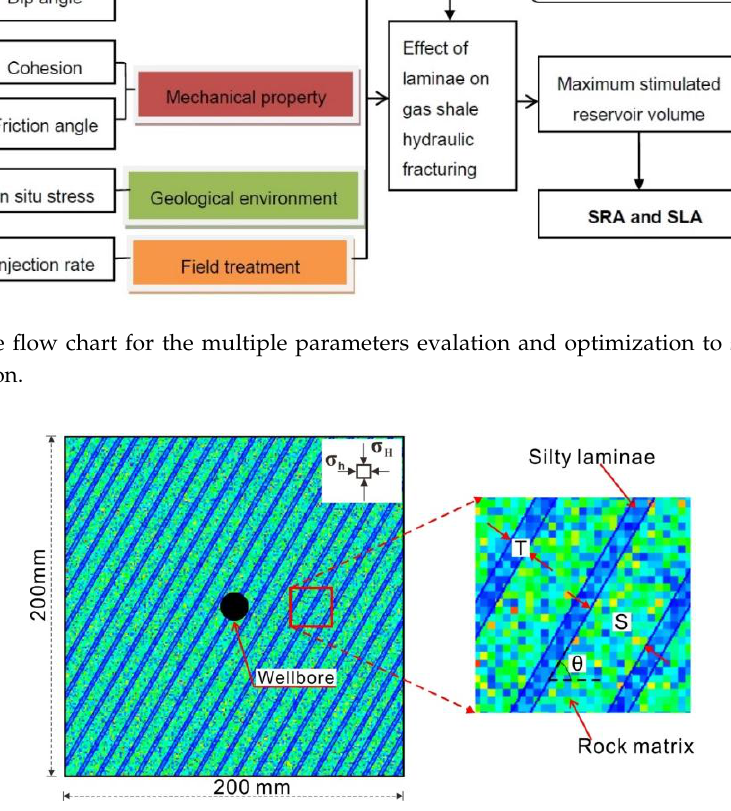
Figure 3. The geometry and model setup.